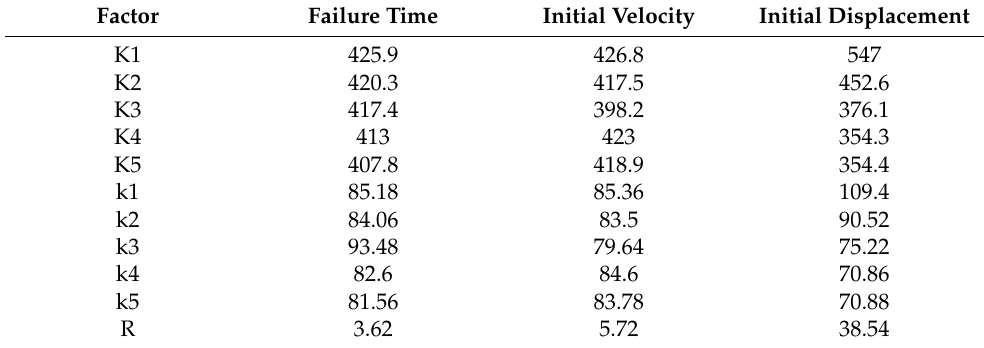
Table 4. Orthogonal test table when bottom corner column fails.